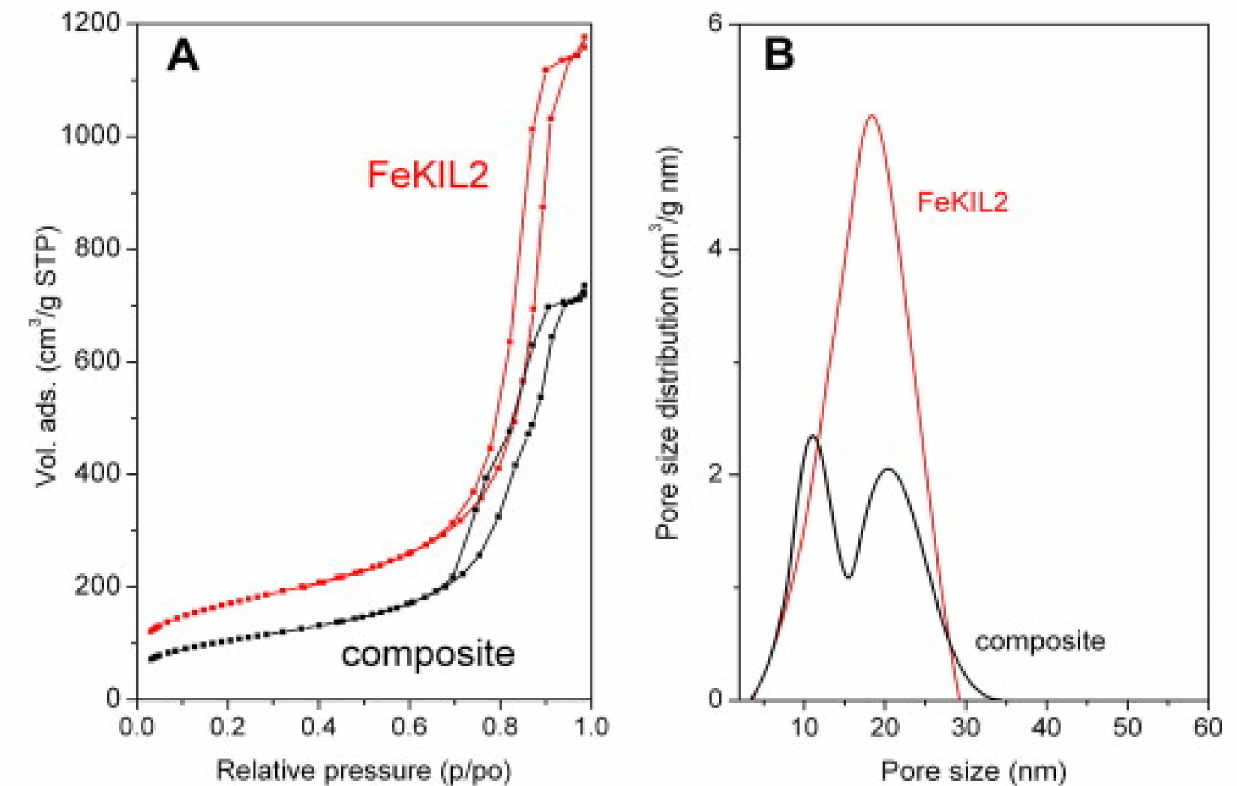
Figure 10. ( A ) Nitrogen sorption isotherms and ( B ) pore size distributions of FeKIL2 and the composite CaCl 2 –FeKIL2 after the cycling test. (Reprinted from [150], copyright (2012), with permission from